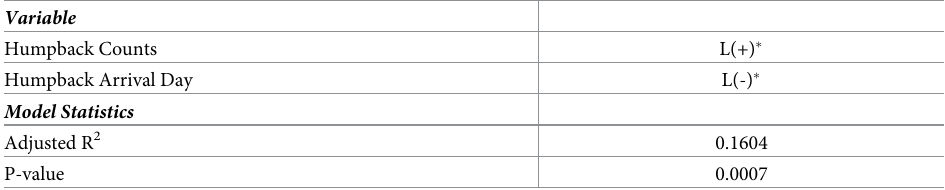
Table 5. Results from the multivariable model for confirmed entangled humpback whales.